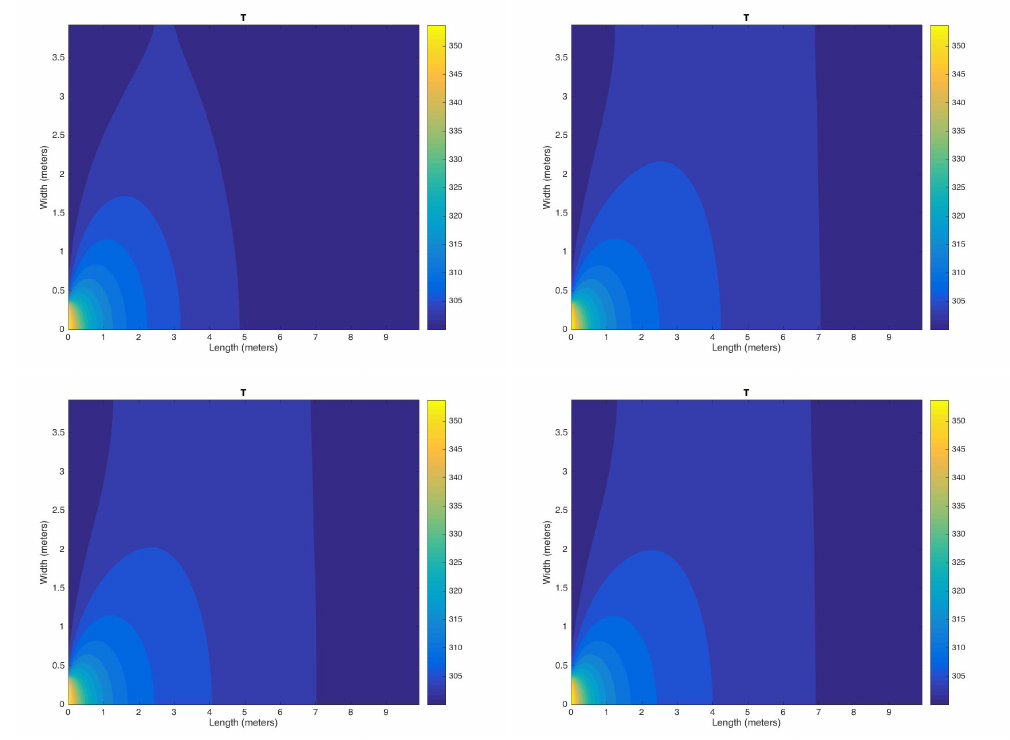
Figure 2. Distribution of the temperature on heterogenous permeability map after 0.35, 0.5, 0.75, and 0.85